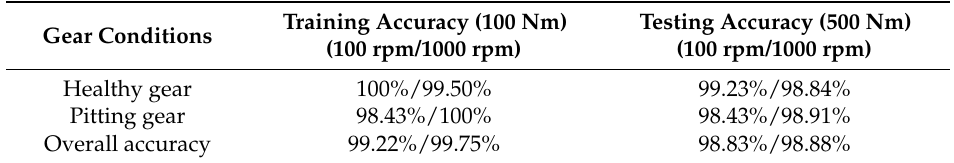
Table 3. Detection results at 100 and 1000 rpm (trained with light loading samples and tested with heavy loading samples).